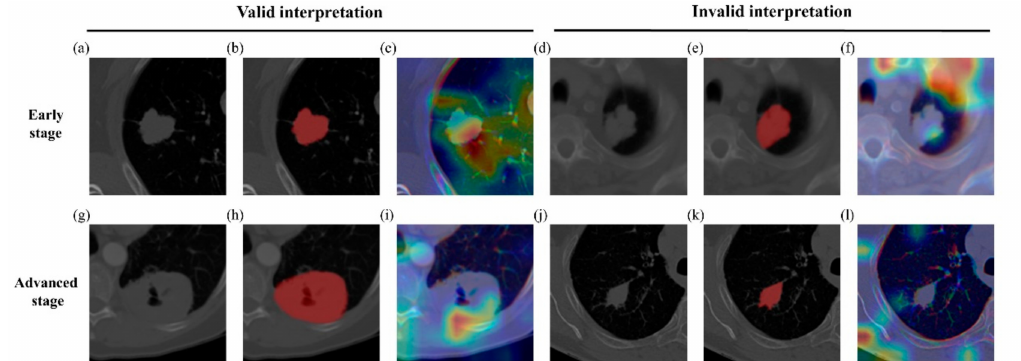
Figure 5. Grad-CAM results. Grad-CAM of classification results. Red represents high contribution and blue stands for low contribution for classification. The first row, ( a – f ), has cases of early-stage samples and the second row, ( g – l ) has cases of advanced-stage samples. The first column, ( a , g ), has input CT images for valid interpretations, while the fourth column, ( d , j ), has input CT images for invalid interpretations. The second column, ( b , h ), shows the ground truth tumor areas for valid interpretations. The fifth column, ( e , k ), shows the ground truth tumor areas for invalid interpretations. The third column, ( c , i ), has activation maps from ( a , g ). The last column, ( f , l ), has activation maps from ( d , j